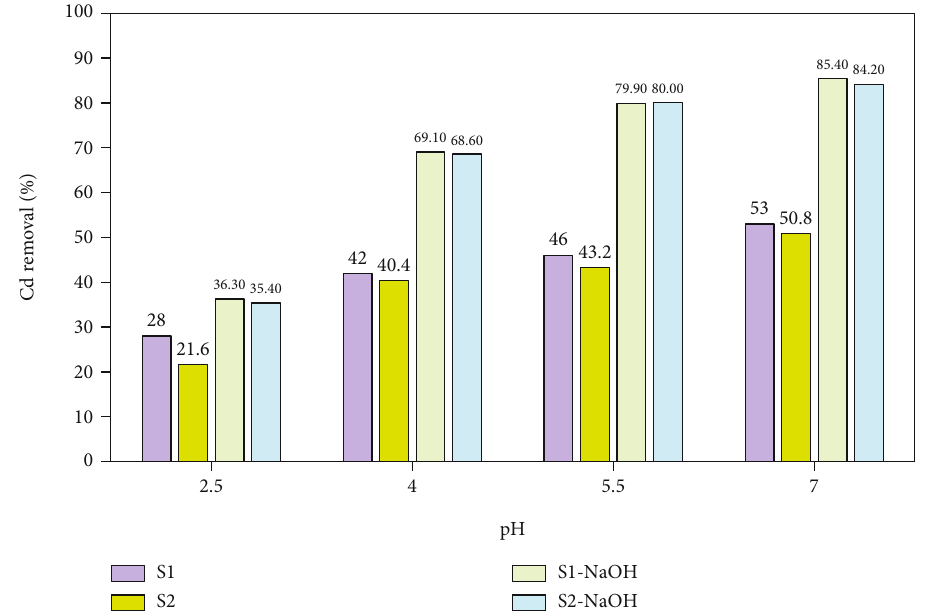
Figure 6: Cd removal percentage at di ff erent pH values, using 150mg rice husk size S1: < 212-425 μ m > and 150mgS2: < 425-600 μ m > , 20mg/L of Cd (II).